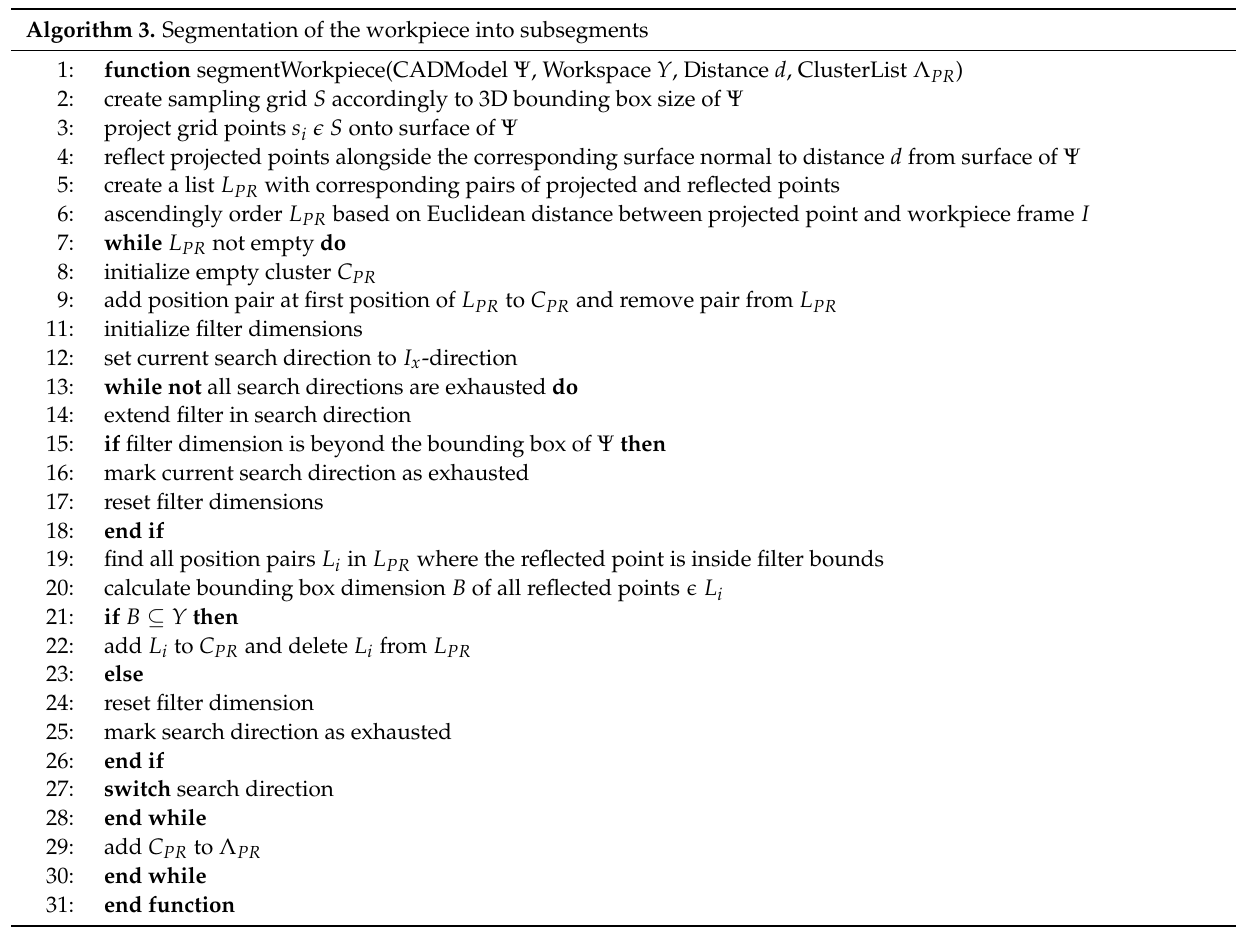
Algorithm 3. Segmentation of the workpiece into